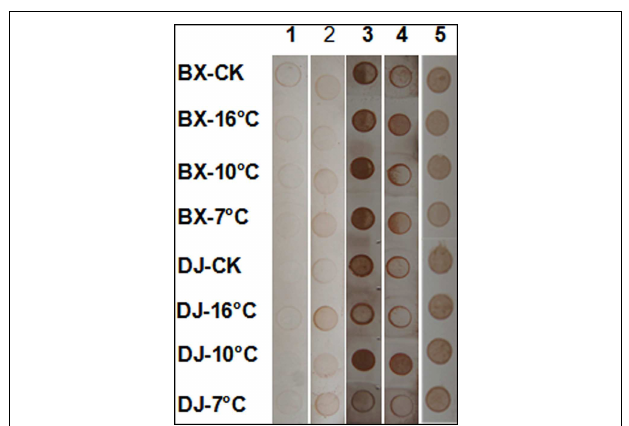
FIGURE 8 | Changes in the levels of individual AGPs in banana leaves exposed to different temperatures using pectin (lanes 1, 2) and AGP extracts (lanes 3–5) probed by immuno-dot analysis. 1, CCRC-M32 antibody; 2, JIM4 antibody; 3, LM2 antibody; 4, LM14 antibody; 6, JIM16